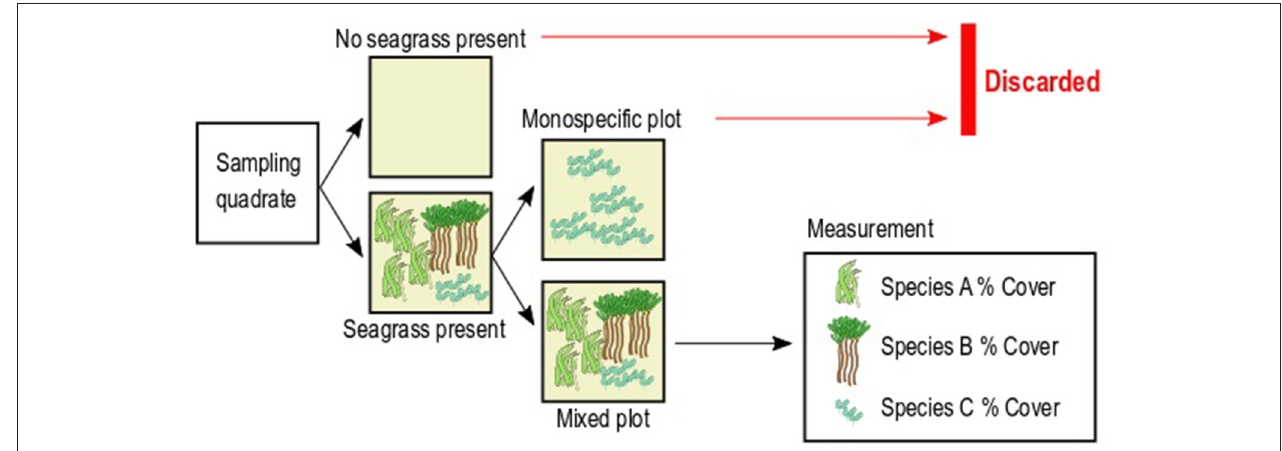
FIGURE 2 | Schematic representation of the sampling design to measure seagrass cover percentage.